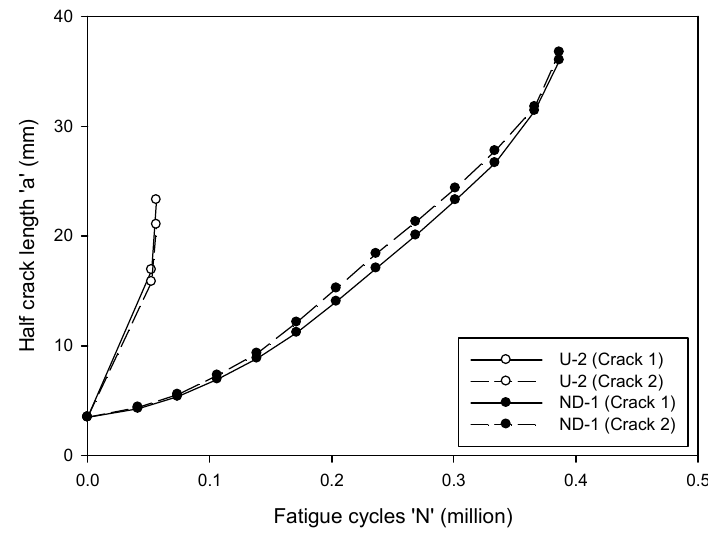
Figure 9. Comparison of fatigue crack propagation between Crack 1 and Crack 2.